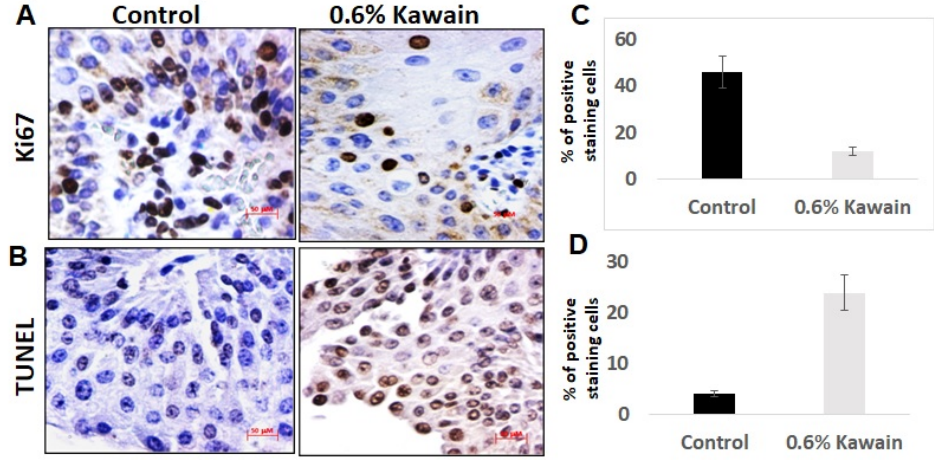
Figure 4. Kawain diet decreases cell proliferation and promotes apoptosis in tumor tissues. ( A , B ) Brown-colored positive cells for Ki-67 (proliferative marker) and TUNEL (apoptotic marker) were shown at × 200 magnification from representative IHC-stained bladder tumor sections randomly selected from six mice fed with indicated diet. ( C , D ) Quantitative results of positive-staining cells form 12 fields in each section from each group. Mean ± SD in histography was shown and Student’s t-test used. All p -values are <0.01.